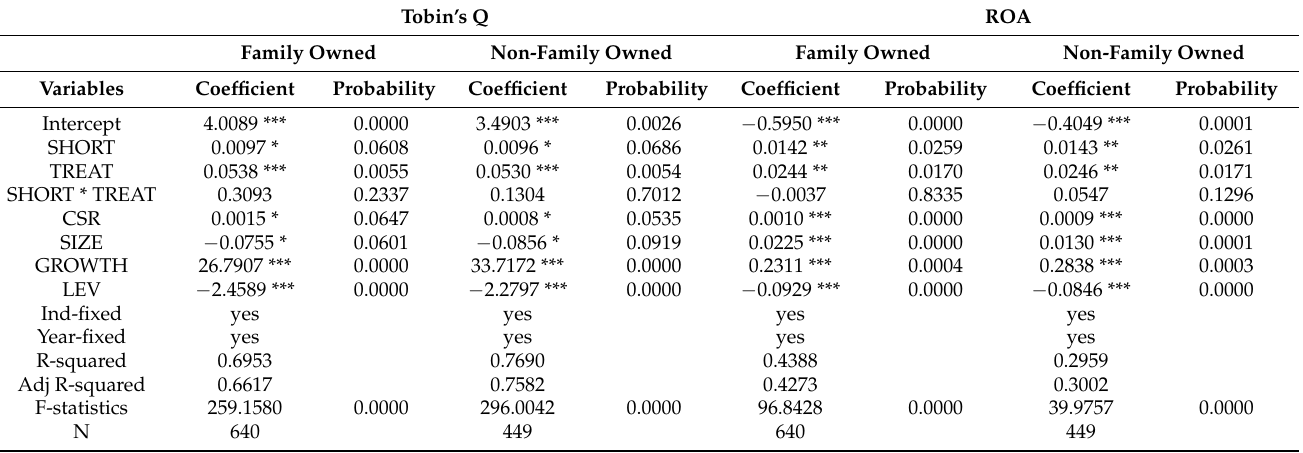
Table 7. Moderating effect of family